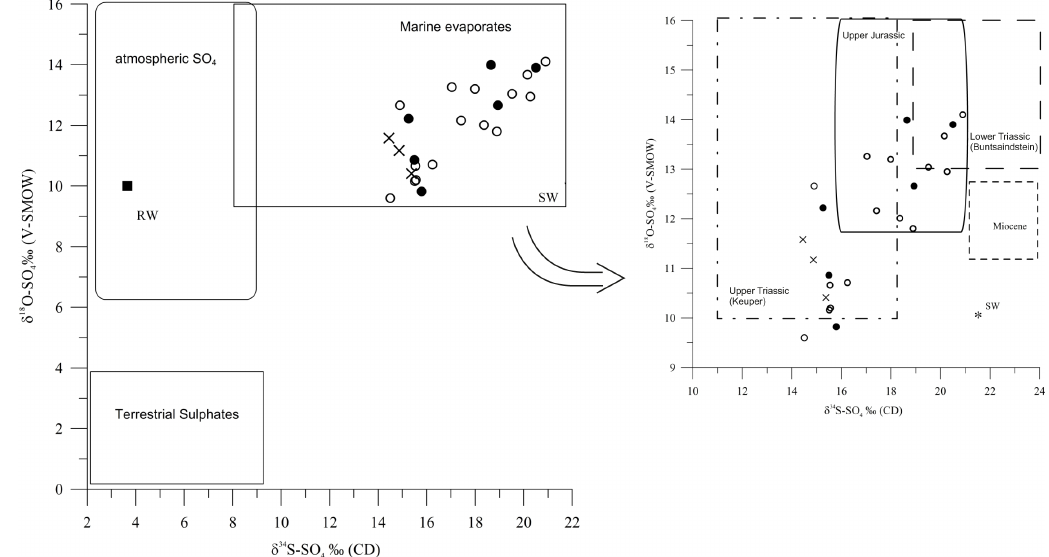
Fig. 10. δ 34 S-SO 4 vs. δ 18 O-SO 4 . The isotopic composition data of various sources in the diagram are from Clark and Frits (1997). Additional data from Krouse and Grinenko (1991) have been used for the zoom of the diagram. The symbols are as in Fig. 5; the crosses represent the isotopic values of the Nurra evaporitic